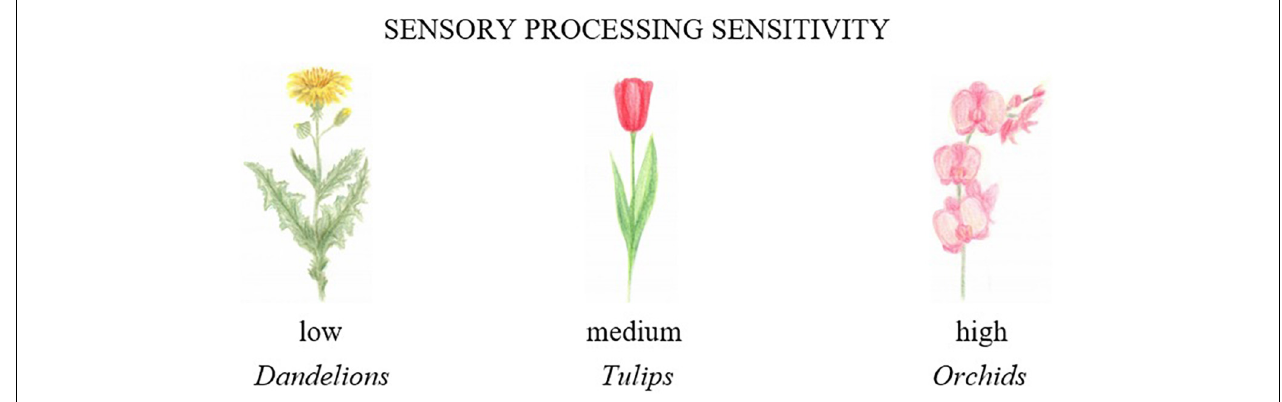
FIGURE 1 | Different levels of sensory processing sensitivity – flower metaphor (Boyce and Ellis, 2005; Lionetti et al., 2018).